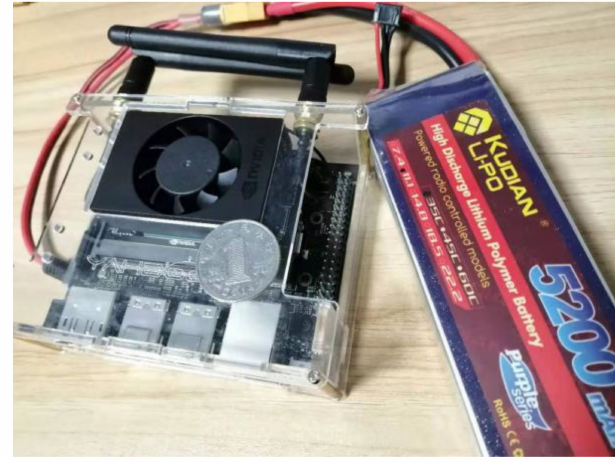
Figure 7. NVIDIA Jetson Xavier NX.